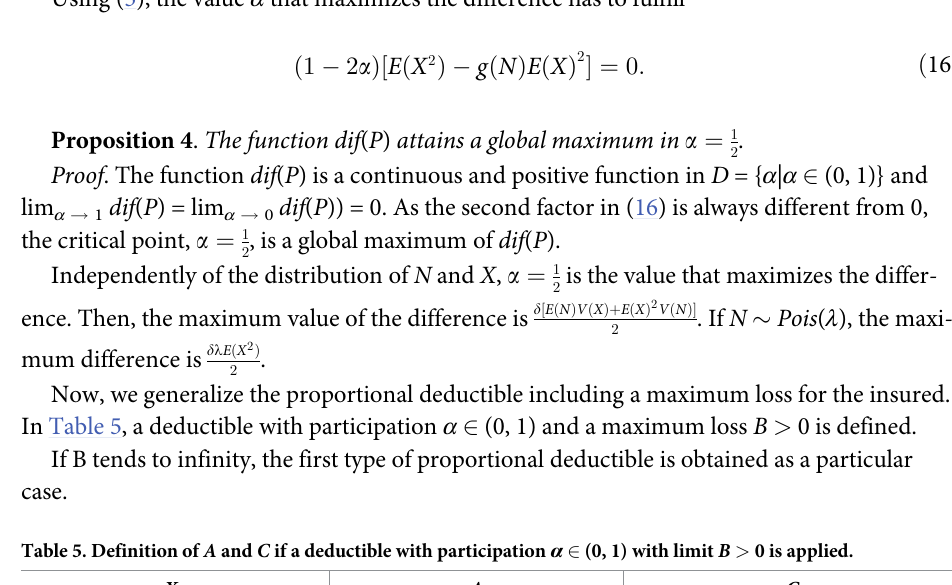
Table 5. Definition of A and C if a deductible with participation α 2 (0, 1) with limit B > 0 is applied. X A C α X (1 − α ) X X < B a X > B a